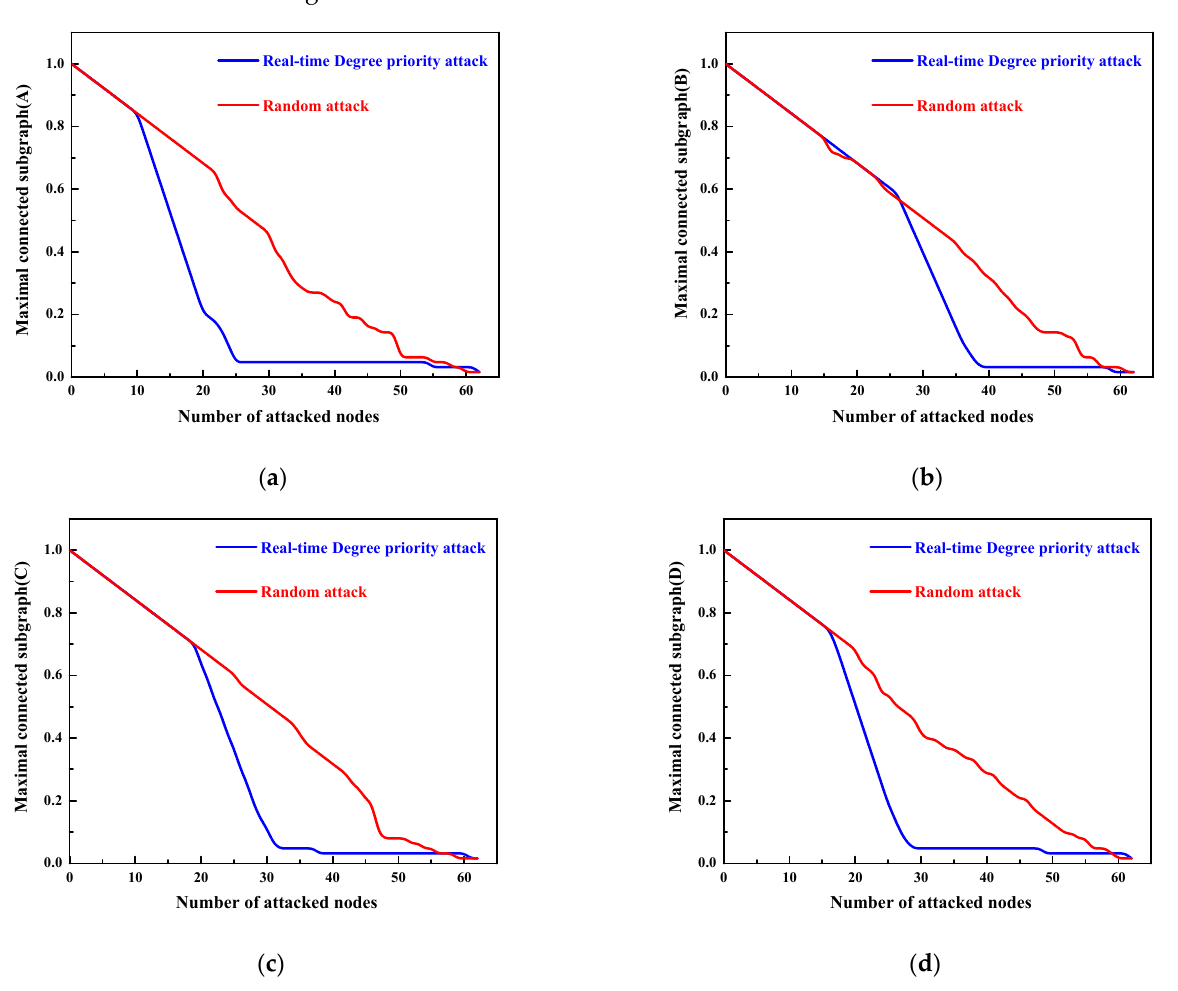
Figure 8. Graph of maximal connected subgraph under two attacks. ( a ) Network A; ( b ) Network B; ( c ) Network C; ( d ) Network D.